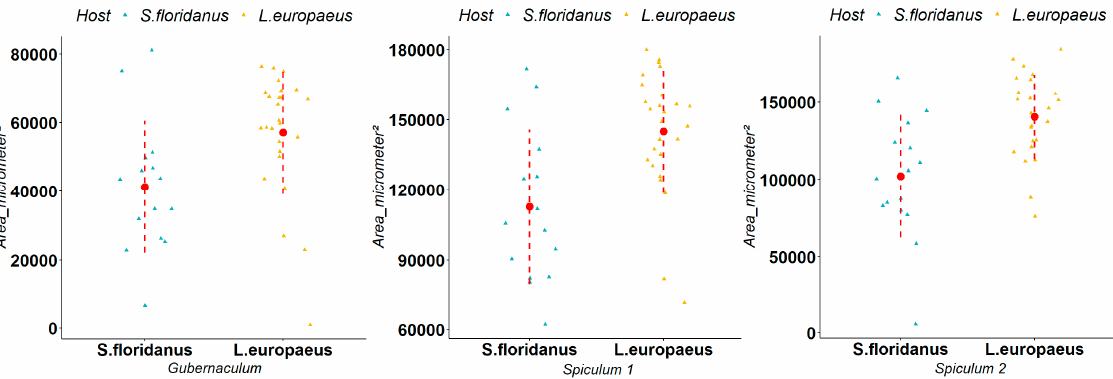
Figure 6. Comparison of the gubernaculum, spiculum 1 and spiculum 2 of Trichostrongylus affinis in Lepus europaeus and Sylvilagus floridanus (measurements shown in μ m 2 ). The triangles represent the single observations, the red dots represent the average values, while the red dashed lines represent the standard deviation.